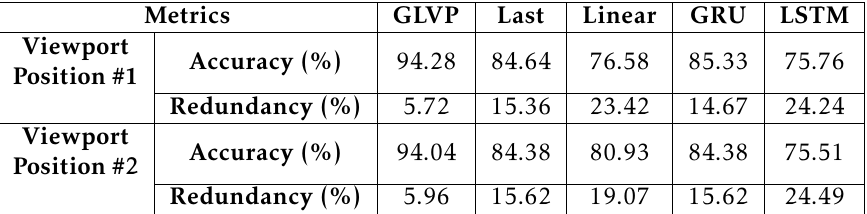
Table 1. Performance of the GLVP and reference methods under viewport positions #1 and